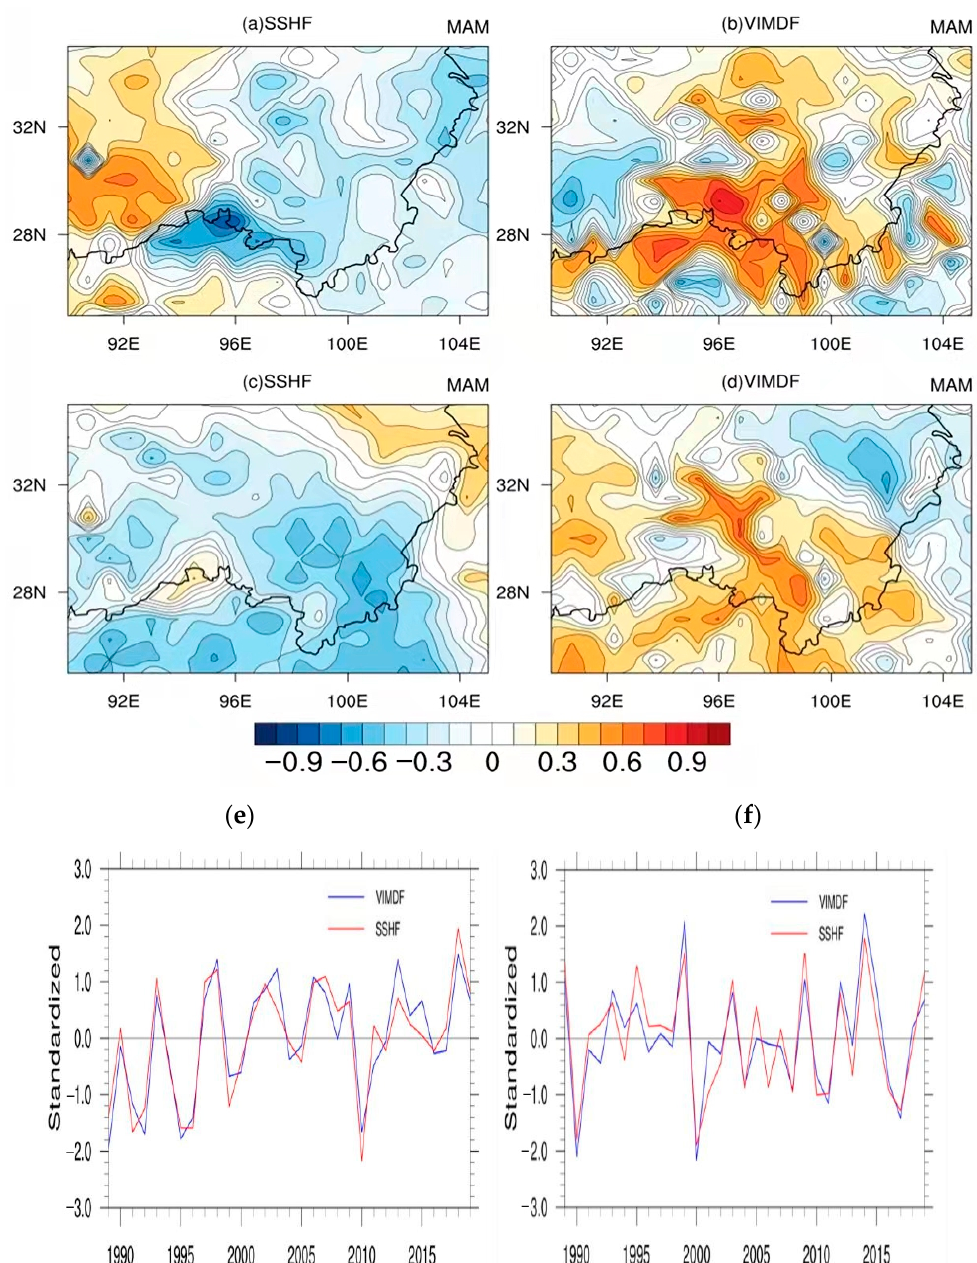
Figure 4. ( a – d ) SVD analysis and ( e , f ) corresponding time series of the spring sensible heat field and the water vapor flux divergence field in southeastern Tibet during the non-AMS. ( a ) the first mode of the thermal field; ( b ) the first mode of water vapor flux divergence field; ( c ) the second mode of the sensible heat field; ( d ) the second mode of the water vapor flux divergence field; ( e ) the first mode; and ( f ) the second mode. The solid black line is the boundary of the Tibetan Plateau in ( a – d ). The solid red line is SSHF time series and the solid blue line is VIMDF time series in ( e , f